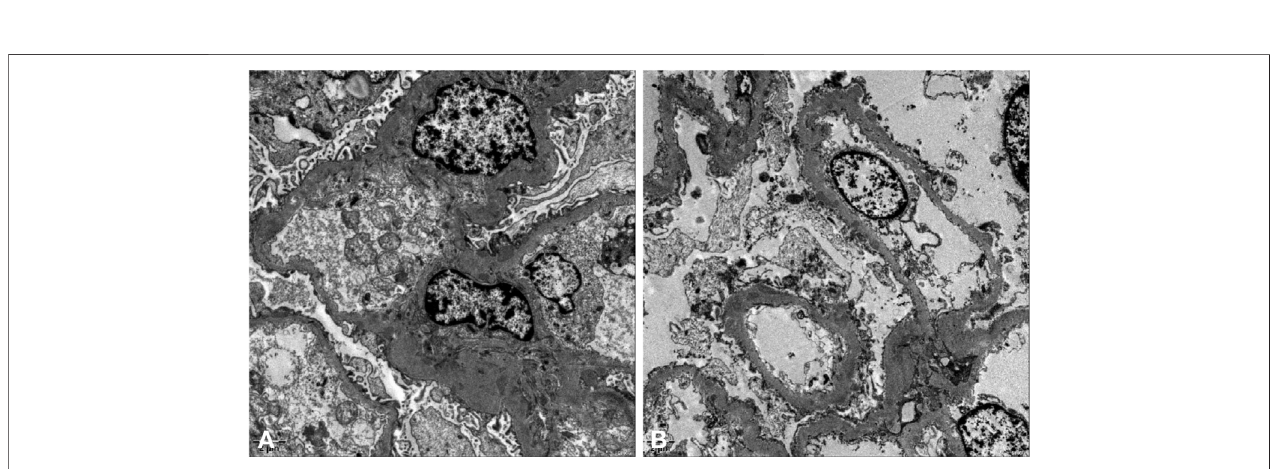
FIGURE 3 | Electron micrographs. Mild, irregular thickening of the GBM and electron-dense deposits in the subepithelial side of the GBM (A,B) .